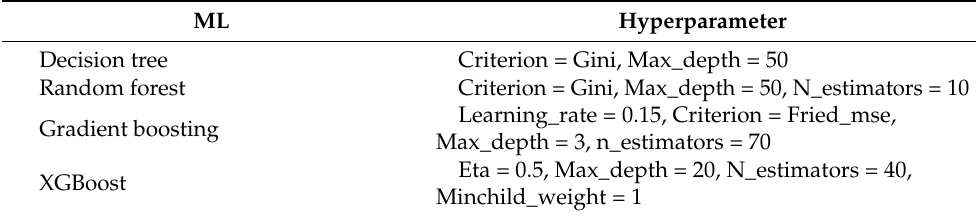
Table 4. Setting up machine learning (ML) hyperparameters for the detection of the 13